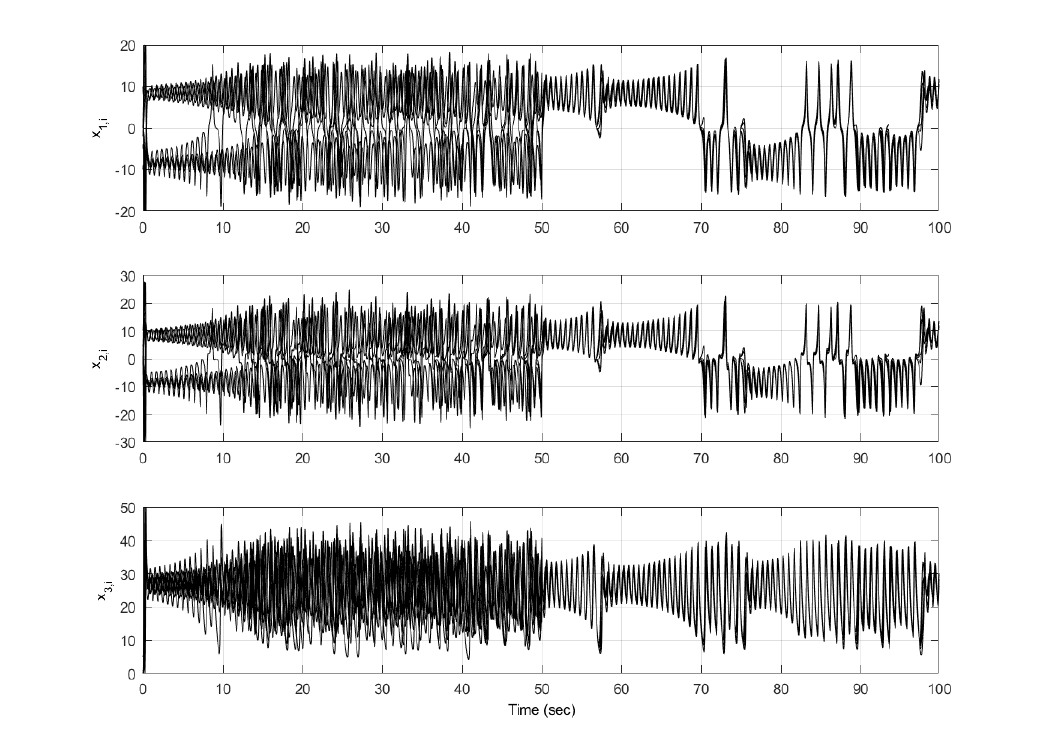
Figure 8. Synchronization state of the network for evolutionary